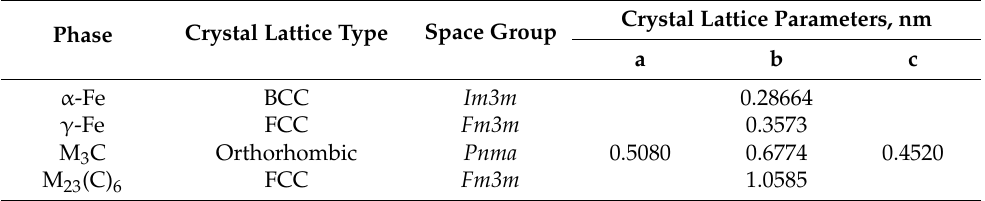
Table 2. Type, space group, and parameters of crystal lattices of α -phase, γ -phase, and carbides.